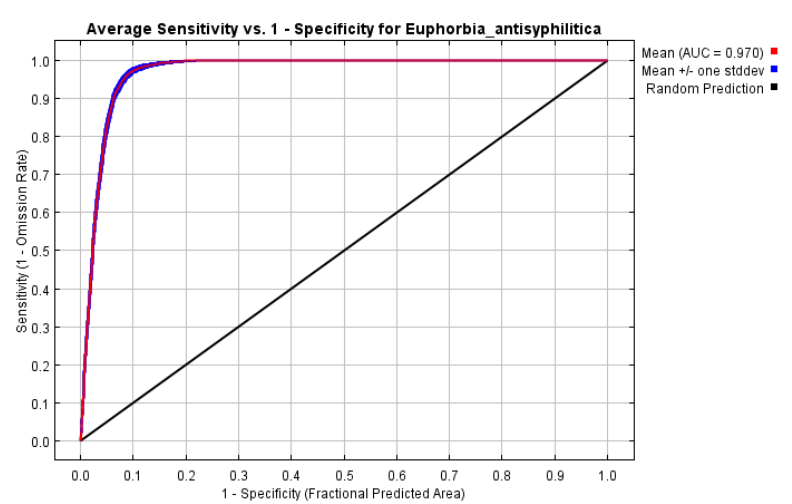
Figure 2. Mean value for the area under the curve (AUC) with 50 reproductions planned to a medium- term future (2050).